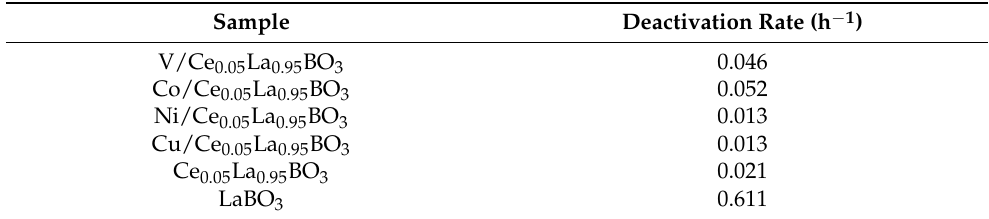
Table 4. The deactivation rates of LaBO 3 , Ce 0.05 La 0.95 BO 3 , V/Ce 0.05 La 0.95 BO 3 , Co/Ce 0.05 La 0.95 BO 3 , Ni/Ce 0.05 La 0.95 BO 3 , and Cu/Ce 0.05 La 0.95 BO 3 .